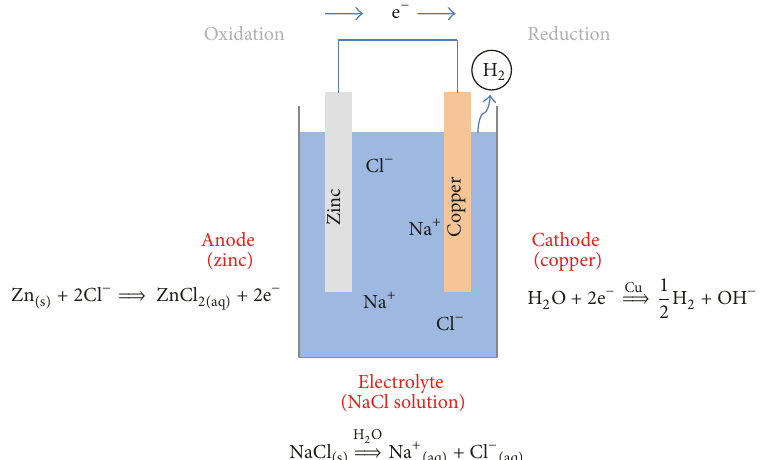
Figure 1: Example of basic battery chemical behaviour.